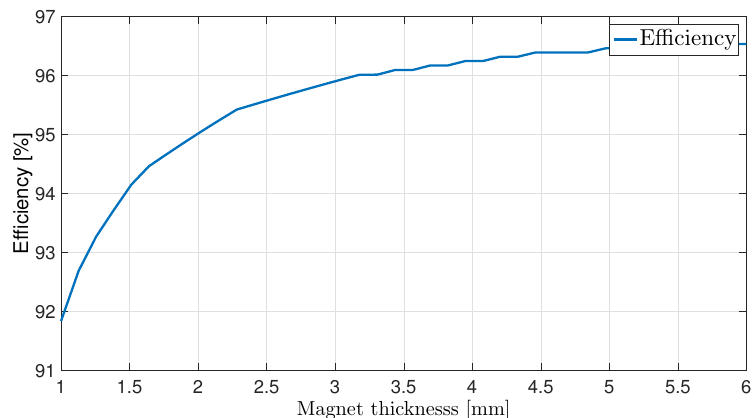
Figure 22. The efficiency variation with the magnet thickness.